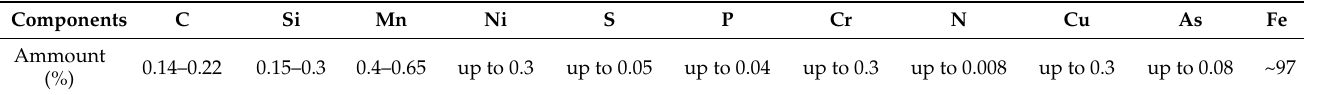
Table 1. Chemical composition of steel